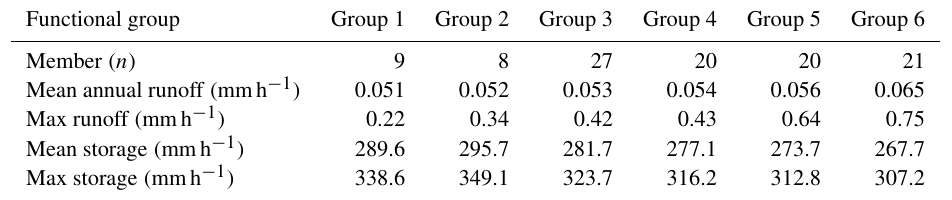
Table 1. Number of members as well as the mean and max values of the runoff simulation of each functional group. Functional